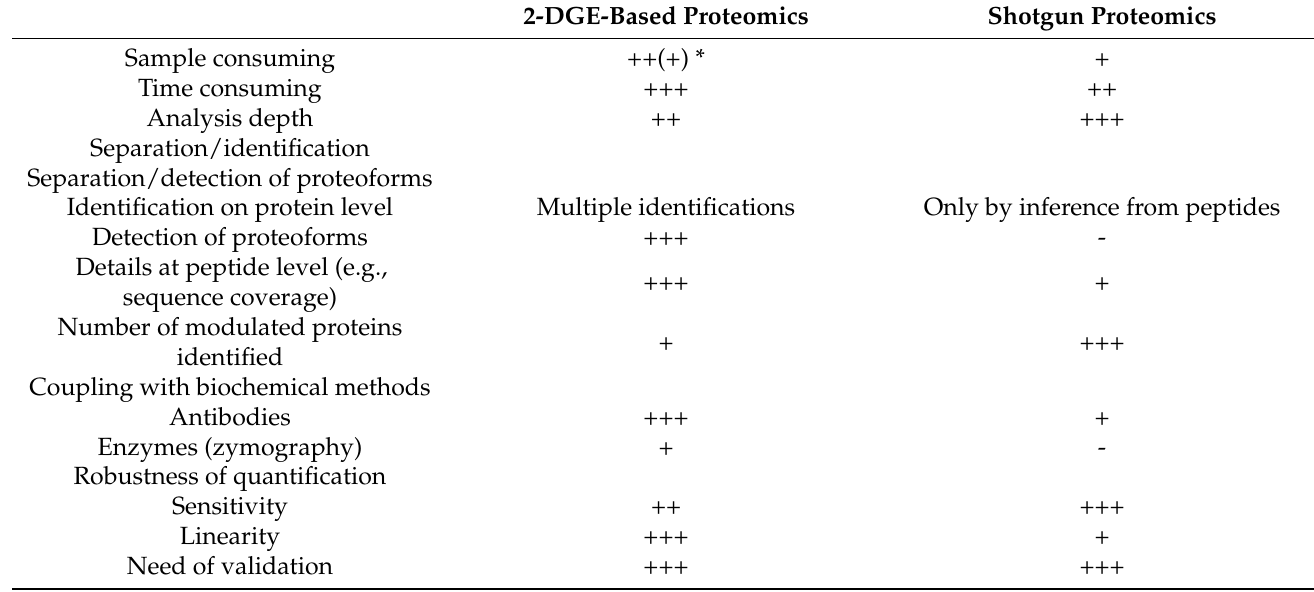
Table 2. Strengths and weaknesses of 2-DGE-based and shotgun proteomics. Table from Marcus et al.